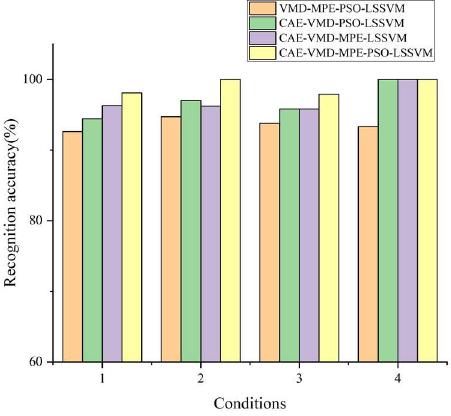
Figure 12. Accuracy rates for the four fault diagnosis methods.